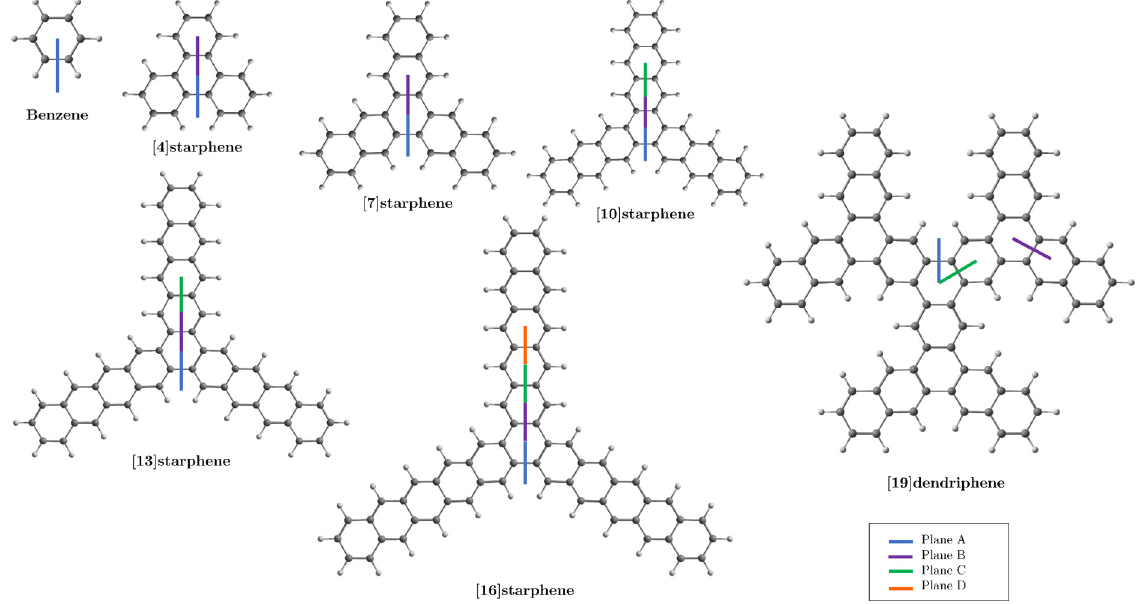
Figure 1. Starphenes studied and the integration planes intersecting their different C–C bonds. The planes of integration extend 8 bohr above and below the molecular plane.